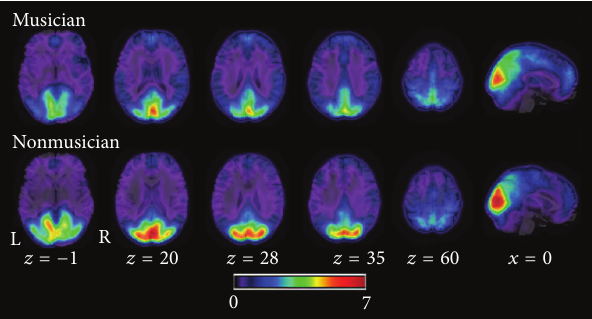
Figure 1: The local FCD maps in two groups (TC = 0.6 ). The upper part represents the averaged local FCD in musicians’ group, and the bottom part represents averaged local FCD in nonmusicians’ group. R, right; L, left.